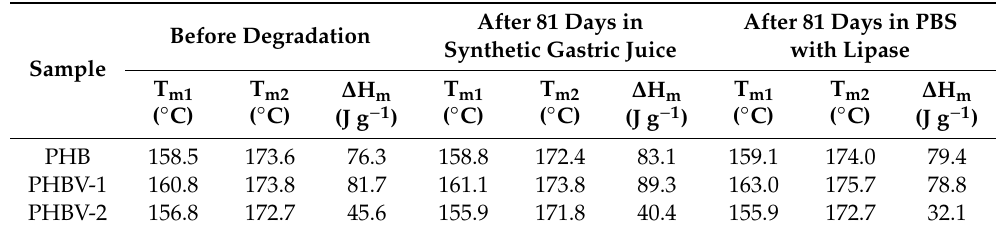
Table 4. Thermal characteristics derived from the first DSC heating